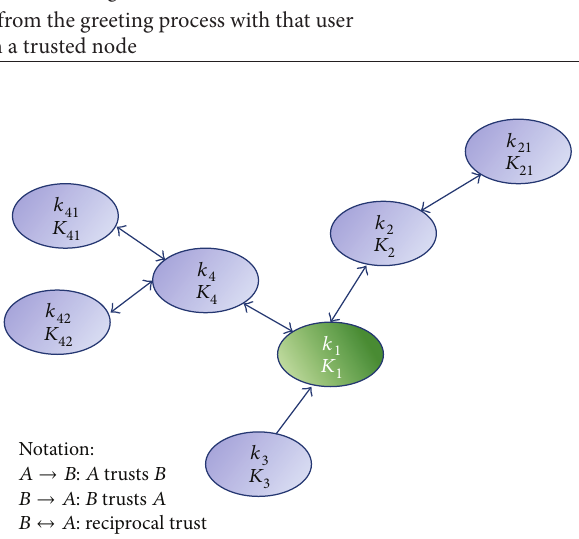
Figure 1: Example of trust